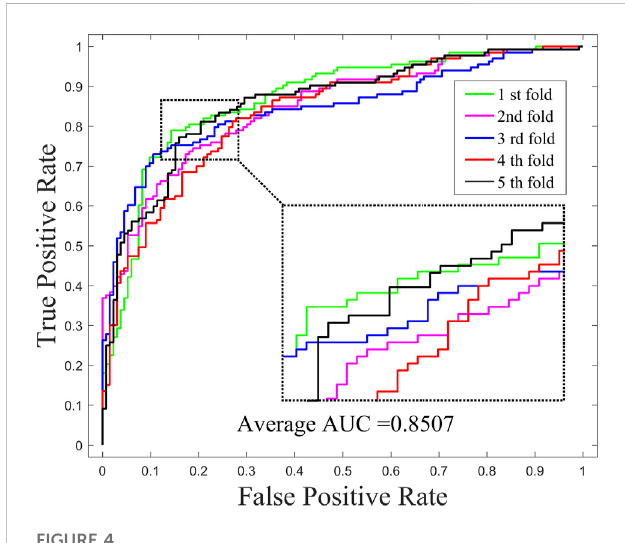
FIGURE 4 The ROC curves of GNMFDMA* for drug-miRNA association prediction under